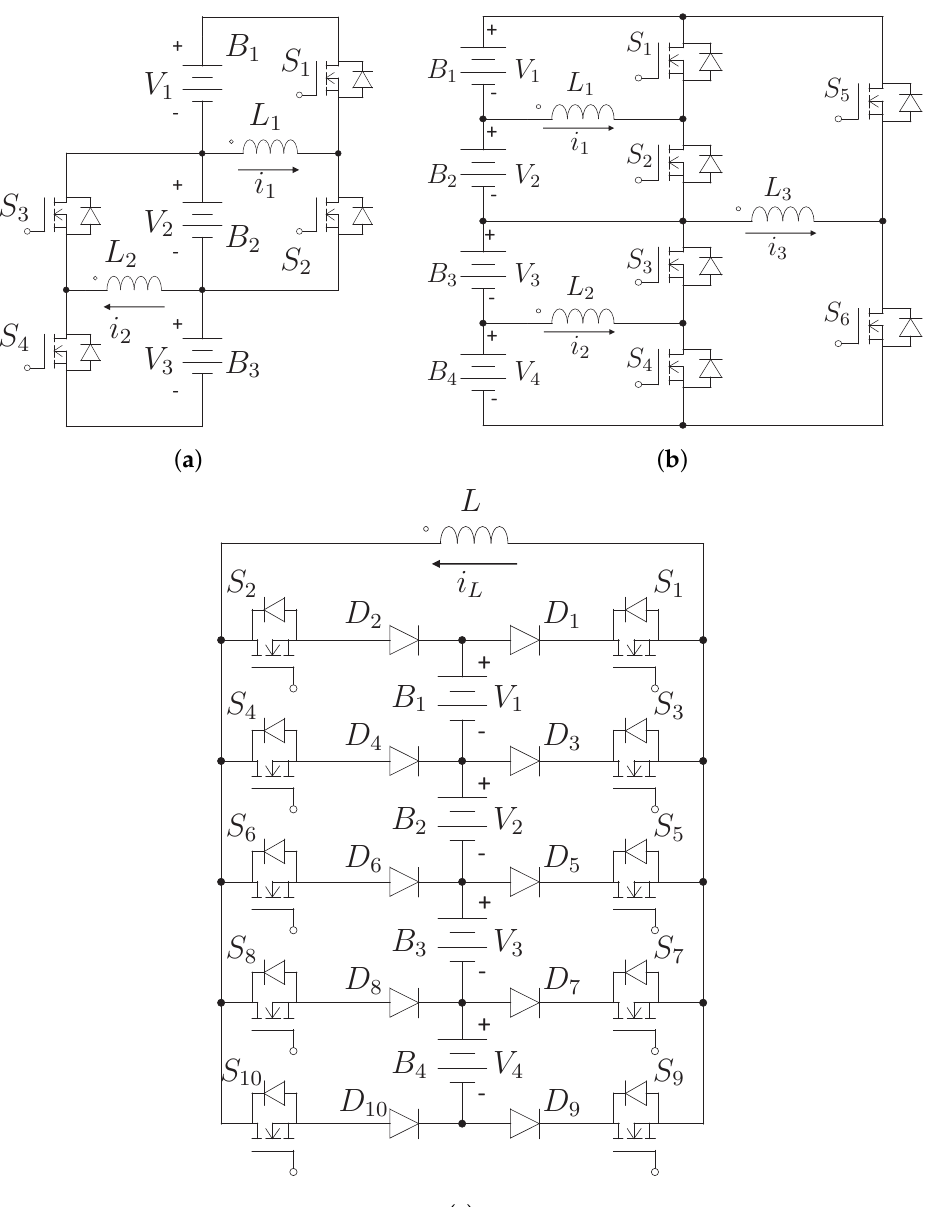
Figure 2. Classic architectures of BECs based on inductors, ( a ) switched-inductor topology, ( b ) layer topology, ( c ) single-inductor